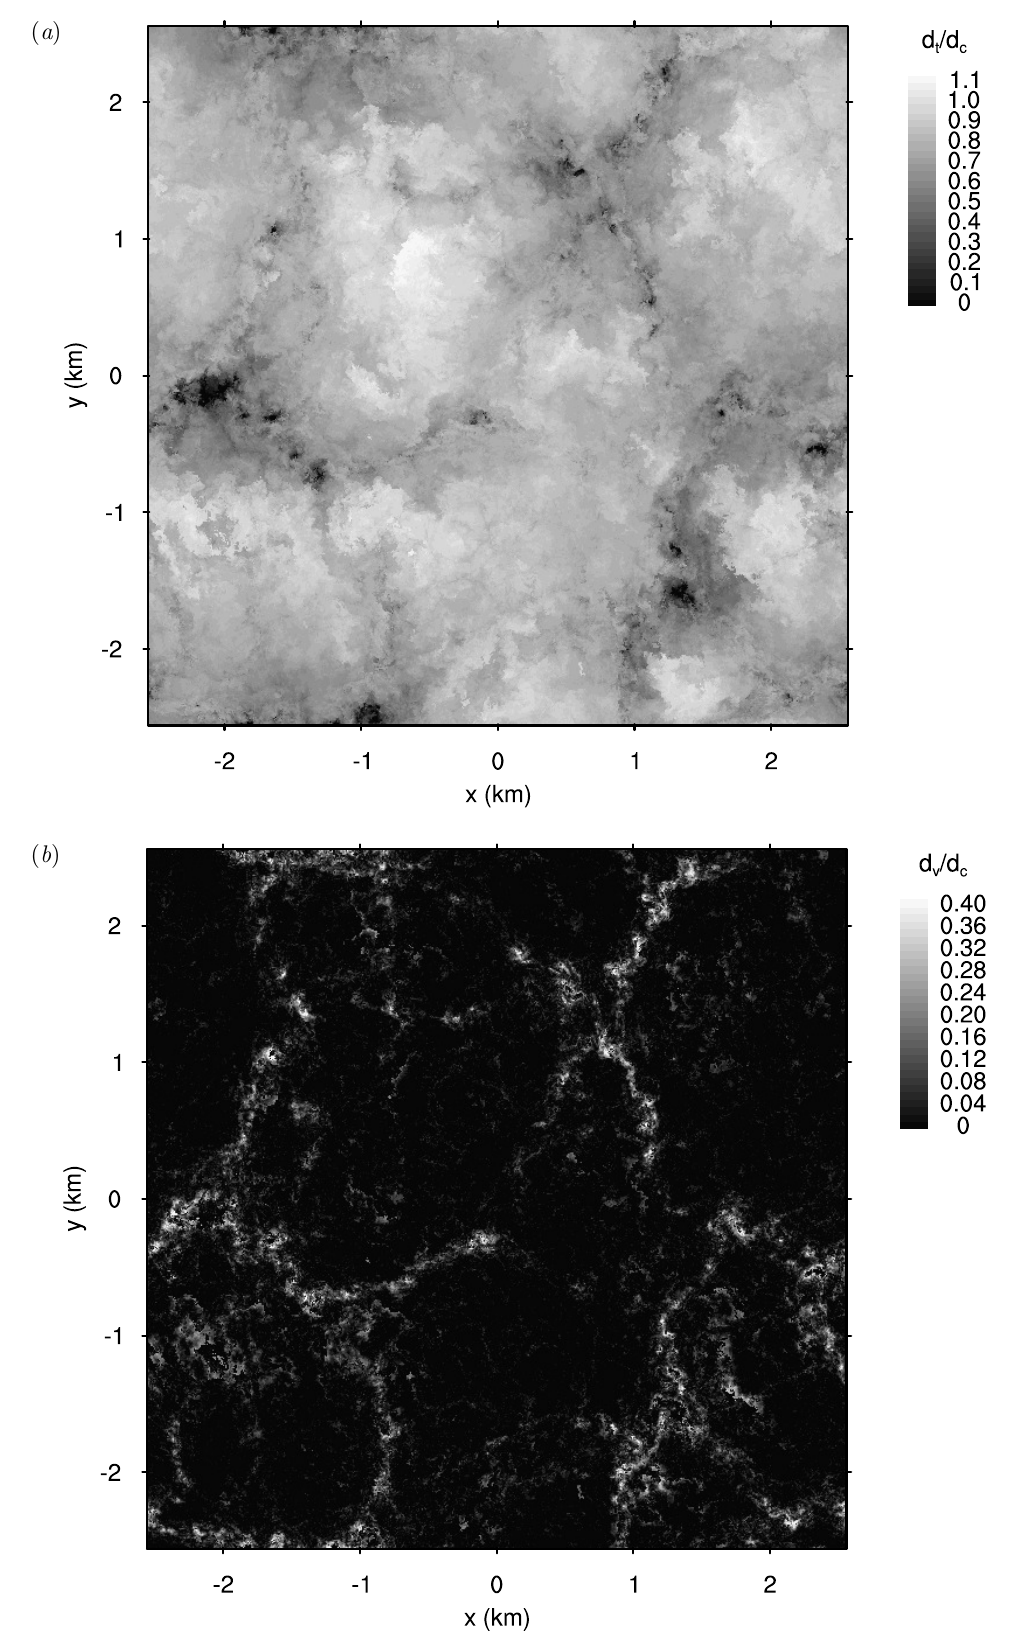
Figure 3. ( a ) Cloud thickness d t and ( b ) total height of cloud voids d v . Both d t and d v are normalized by the cloud mean thickness d c